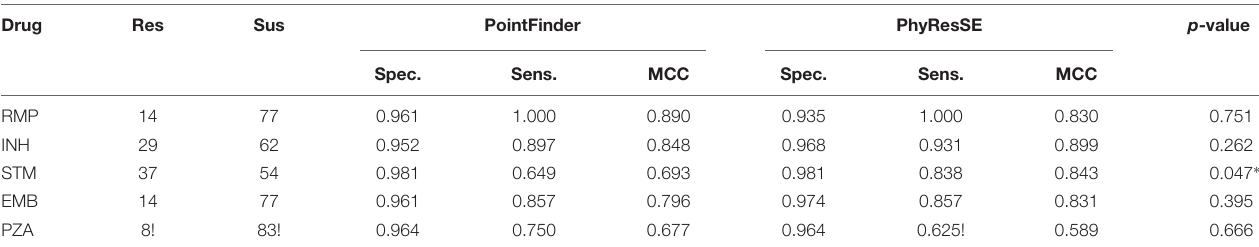
TABLE 9 | Comparing PointFinder and PhyResSE prediction